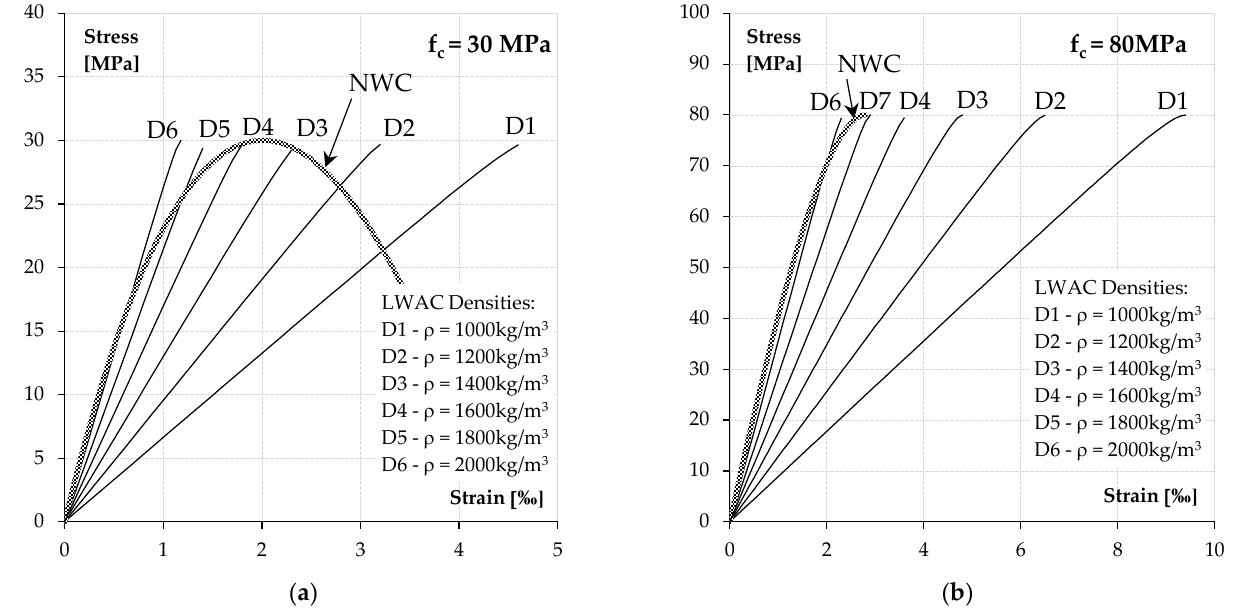
Figure 1. Stress-strain characteristics of LWAC and NWC concrete for two selected strength classes: ( a ) f c = 30 MPa and ( b ) f c = 80 MPa.